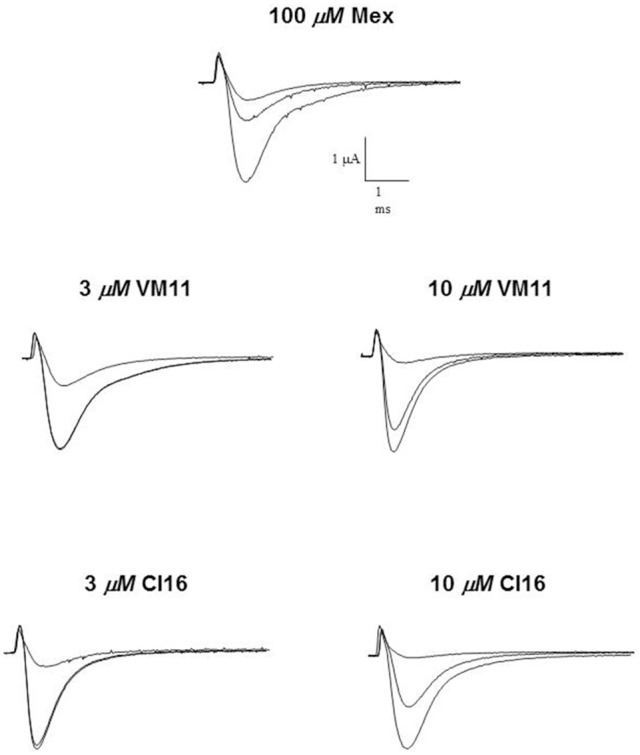
Na+ current transients recorded in the absence and in the presence of 100 μM Mex, 3–10 μM VM11 and 3–10 μM CI16. In each group of traces, the greatest one has been recorded in the absence of drug, with a depolarizing step from the HP of −100 to −20 mV for 10 ms. A similar depolarizing stimulus applied after the application of each compound allowed to estimate the tonic block exerted by the drug (middle traces). The smallest current traces correspond to the residue current at end of the 10-Hz stimulation protocol. In particular, at concentration 3 μM, for bothtetramethyl-pyrroline the trace of the tonic block is superimposed on that of the control.